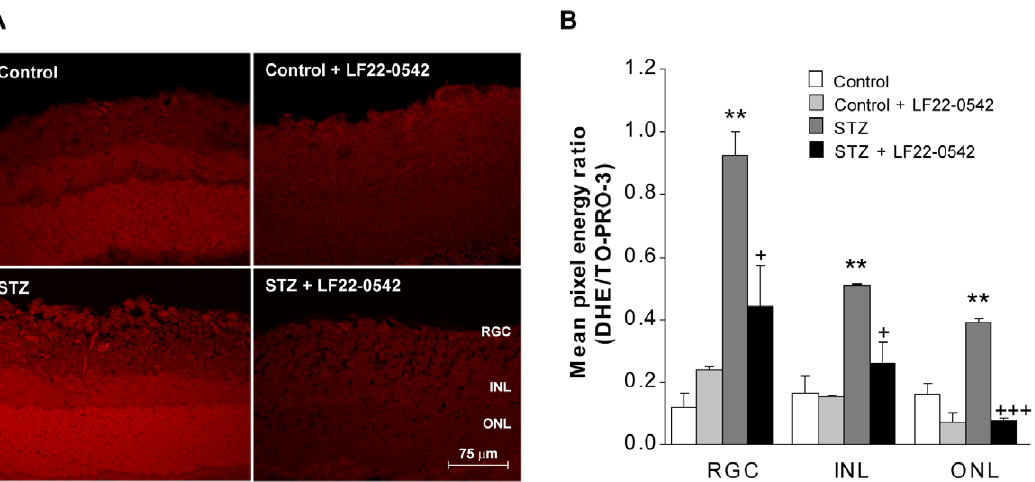
Figure 5. Effect of LF22-0542 on retinal oxidative stress in STZ-diabetic rats. (A) Representative pictures of superoxide anion production stained with dihydroethidine on retinal section from a control rat, a control rat treated with LF22-0542, a STZ-diabetic rat and a STZ-diabetic rat treated with LF22-0542. Scale bar is 75 m m. (B) Fluorescence intensity of superoxide anion was quantify by the evaluation of mean pixel energy ratio of DHE staining versus TO-PRO-3 in the retinal ganglion cells layer (RGC), the inner nuclear layer (INL) and the outer nuclear layer (ONL). Data are mean 6 s.e.m. of values obtained from 3 rats in each group. Statistical comparison with control (*) or STZ ( + ) rats is indicated by **P , 0.01, + P , 0.05, +++ P , 0.001.